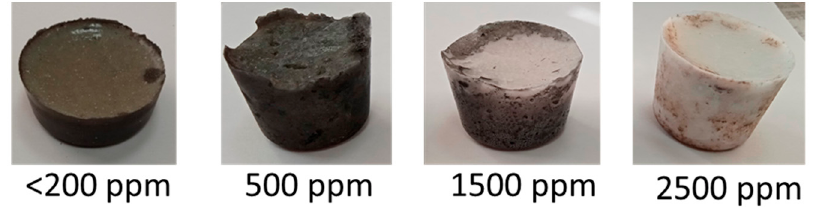
Figure 3. Appearance of the melt after corrosion tests.